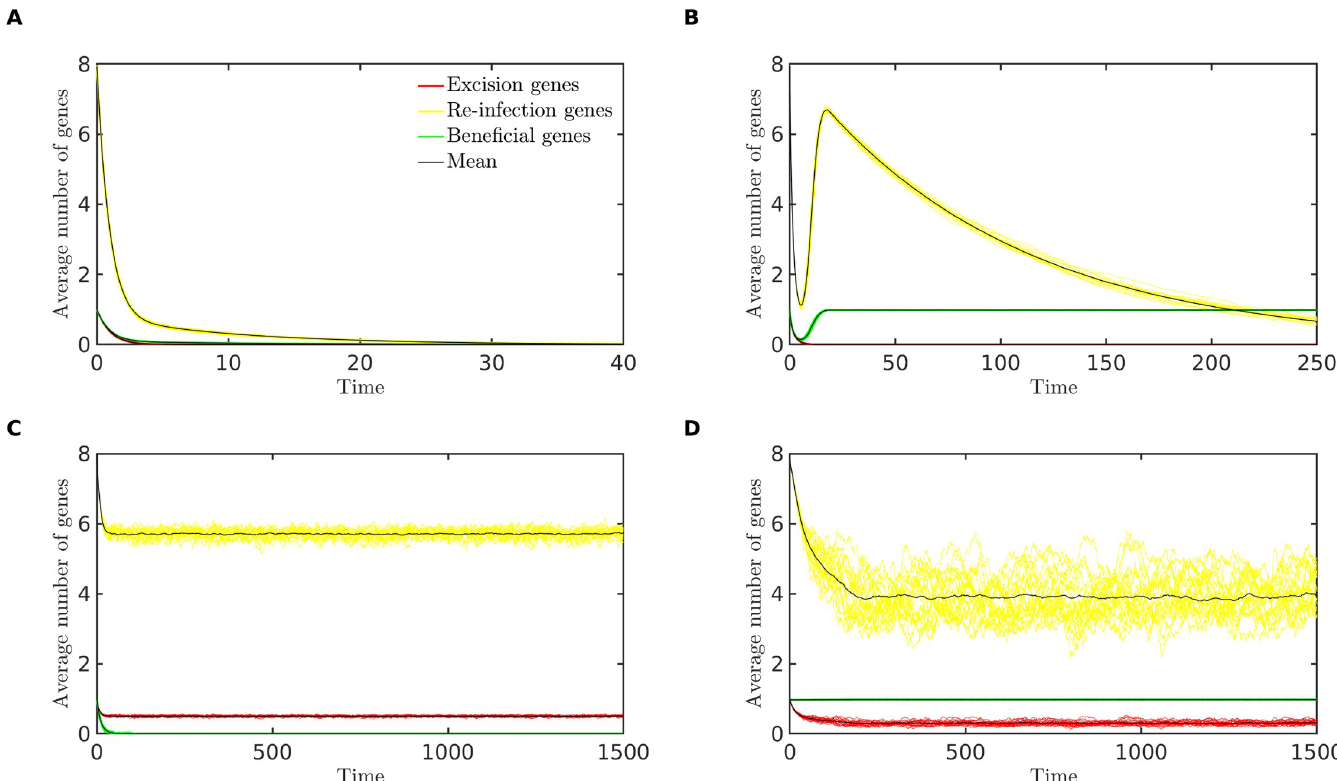
Fig 4. Simulations results showing the approach to four possible long-term outcomes: (A) Extinction ( r S = 0.01, r D = 0.1, r L = 0.2). (B) Domestication ( r S = 0.52, r D = 0.01, r = 0.2). (C) Parasitism ( r = 0.02, r = 0.1, r = 2.0). (D) Persistence ( r = 1.5, r = 0.05, r = 1.5). In all cases, r = 1, r = 0, n = 1, n = 1 and n = 8. The average L S D L S D L I T B E R number of genes of each type, per prophage, is plotted against time, for 20 randomly chosen replicate simulations (colored lines) and for the mean across 100 replicate simulations (black lines). For each replicate, a population of 10,000 bacterial genomes was simulated for 20,000 bacterial generations, over which time each of these long- term outcomes remained stable; here we illustrate the initial approach to these long-term states.